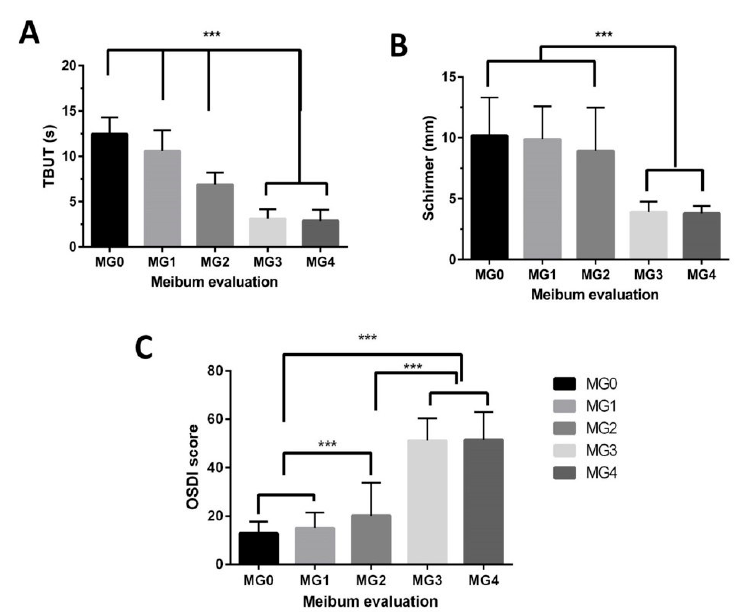
Figure 2. Relationship of meibomian gland dysfunction (MGD) grading with ( A ) tear breakup times